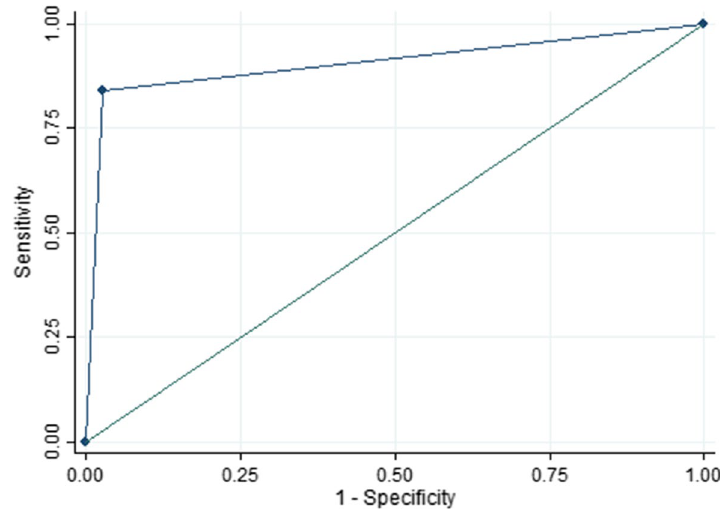
Fig. 6 Pneumonia ROC curve in the test